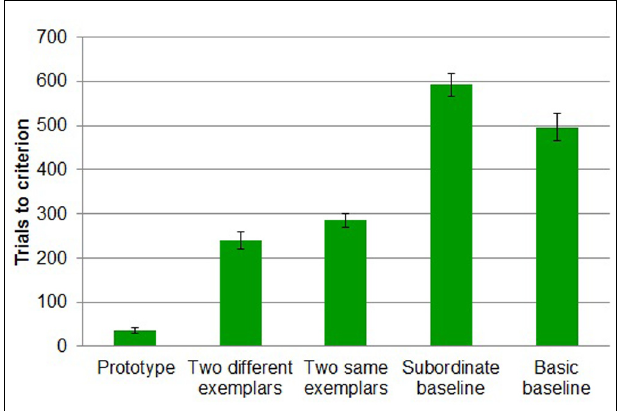
FIGURE 10 | Mean accuracy by transfer condition in Experiment 3. Error bars represent SEs. ** p <